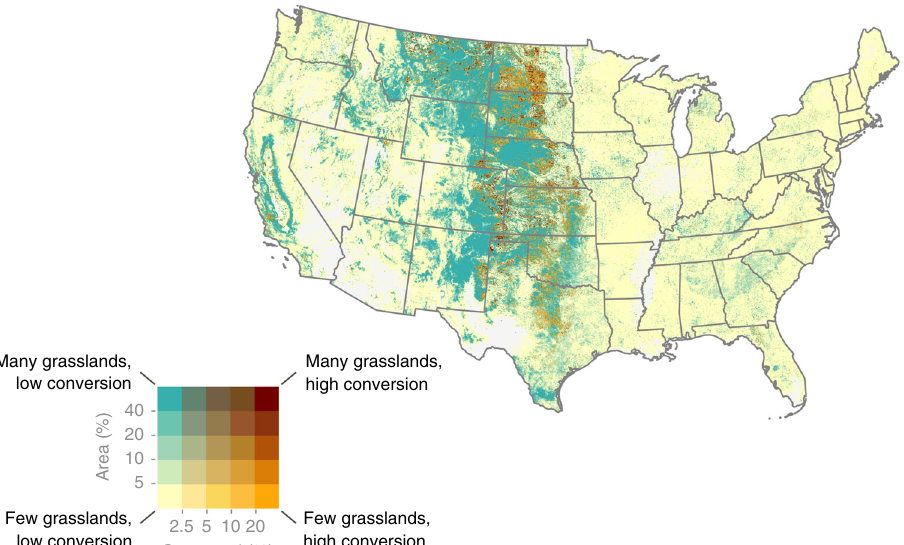
Fig. 6 Long-term grasslands converted to crop production 2008 – 16. Long-term grasslands are those that have not been planted or cultivated for at least 25 years and are most likely to contain native plant species and undisturbed sod. Values displayed re fl ect the percentage of the landscape that is occupied by long-term grasslands ( y -axis) and the percentage of those grasslands that were converted ( x -axis). Conversion (orange color) was highest along a north-south transect of the Great Plains, which represents a westward frontier of cropland expansion into remaining long-term